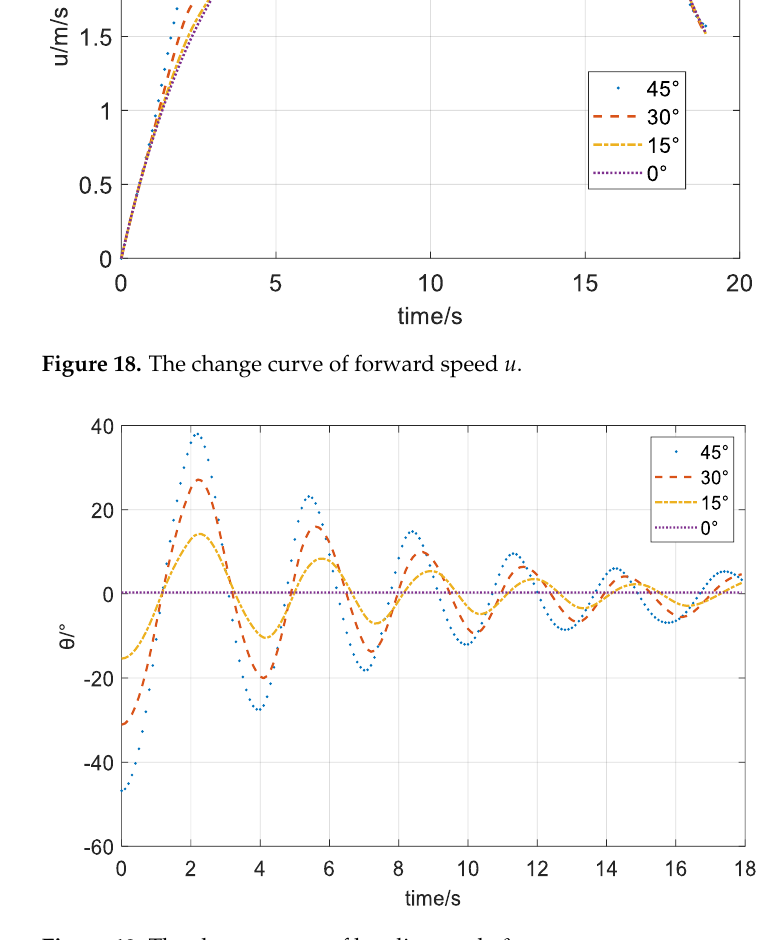
Figure 19. The change curve of heading angle θ .